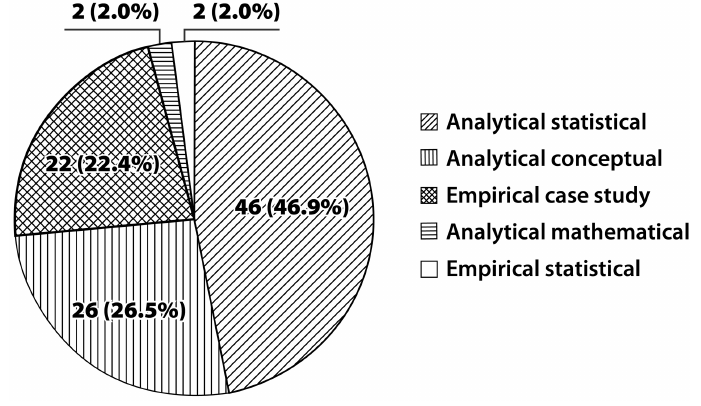
Fig. 4. Research strategies in mobile payments research.